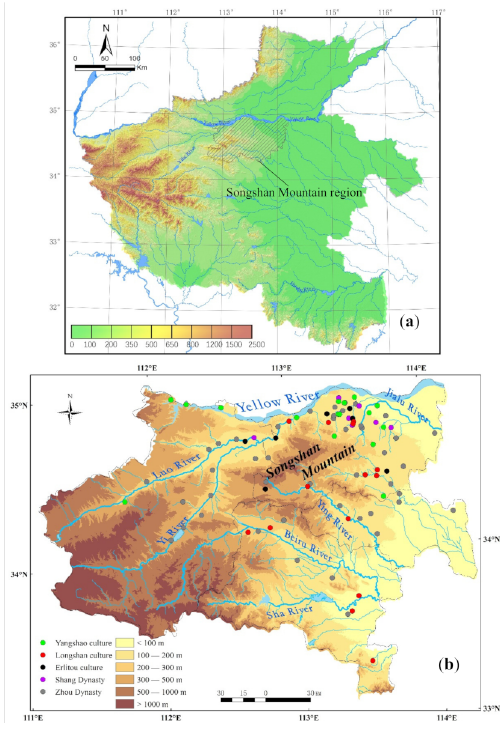
Figure 1. ( a ) The location of Songshan Mountain region. ( b ) The Neolithic-Bronze cities in Songshan Mountain